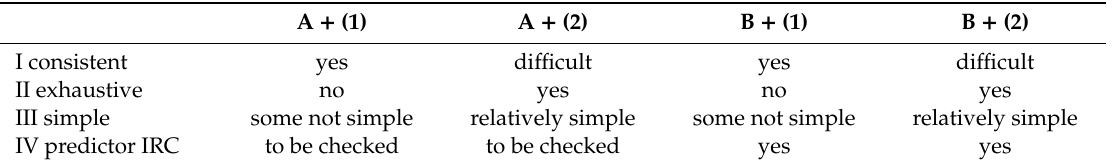
Table 2. Compliance of approaches A and B and variants (1) and (2) with the desired properties of the GRHI. A + (1) A + (2) B + (1) B +